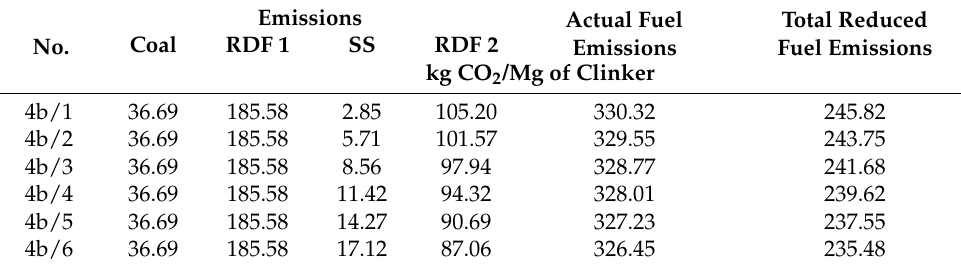
Table 10. The CO 2 emissions balance of blends of coal with RDF 1-RDF 2-SS (4b–four components).